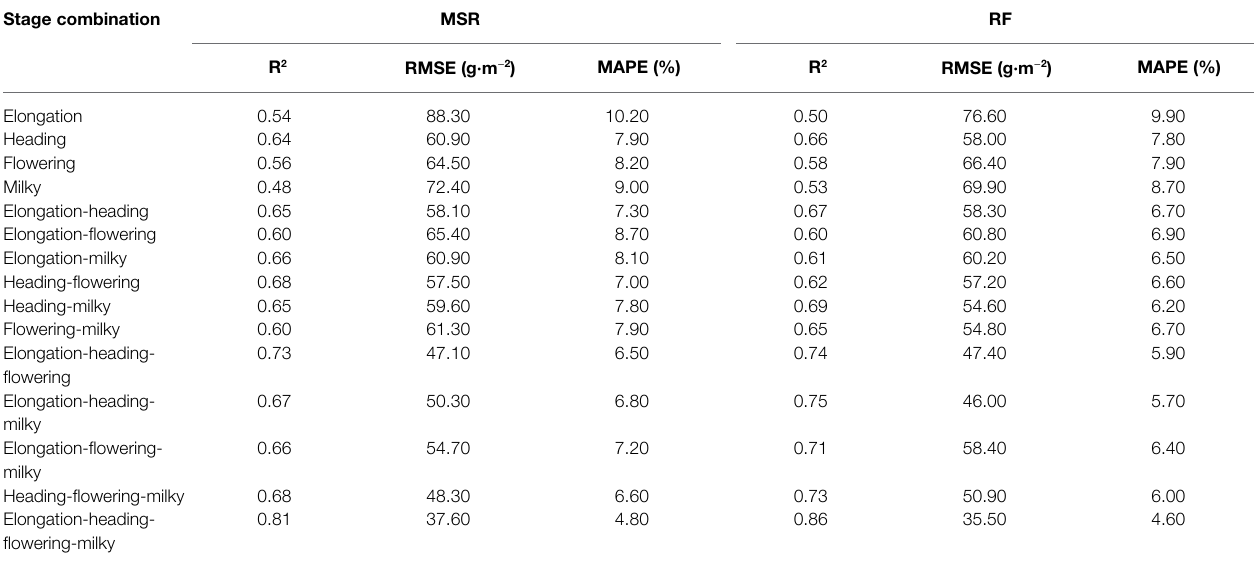
TABLE 6 | Rice yield prediction model based on first derivative-wavelet transform. Stage combination